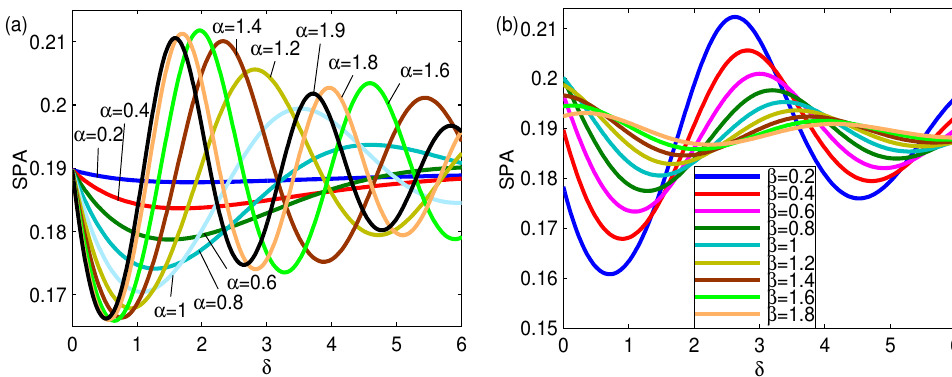
Figure 4. GSR behaviors of SPA( δ ) in (36) for distinct ( a ) α and ( b ) β . ( a ) ¯ γ = 0.1, β = 0.4, τ = 0.2, ω 0 = 1, Ω = 2, µ = ν = 0.8; ( b ) ¯ γ = 0.1, α = 1.2, τ = 0.2, ω 0 = 1, Ω = 2, µ = ν = 0.8.